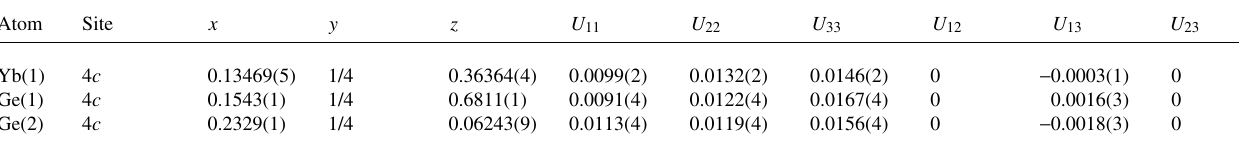
Table 3. Atomic coordinates and displacement parameters (in Å 2 ) .